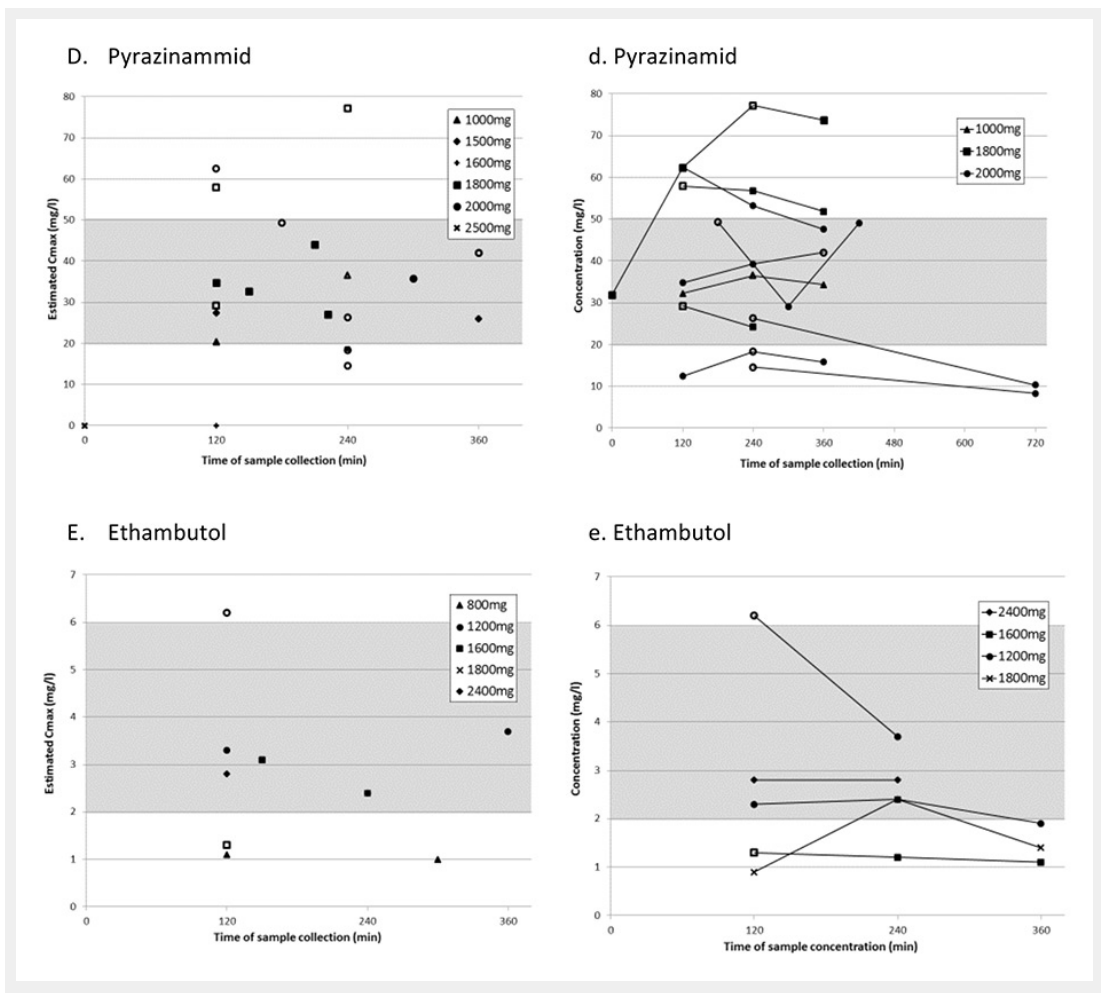
Figure 1 Panels A-E represent the highest measured concentration (estimated C max ) from each sampling period for each antituberculosis drug with its corresponding dosages. Panels a-e represent sampling periods with multiple consecutive measurements. For all panels: Grey area shows published reference ranges [13]. White symbols represent antituberculosis drug levels determined during multiple sampling periods, black symbols represent levels determined in periods with only one sample